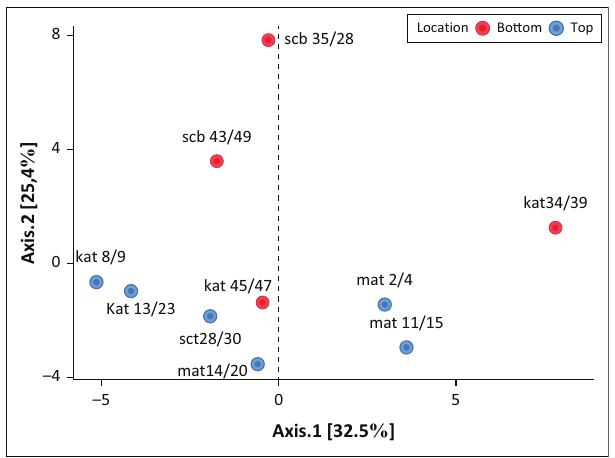
FIG URE 5: Potential functional capacity for each sample.